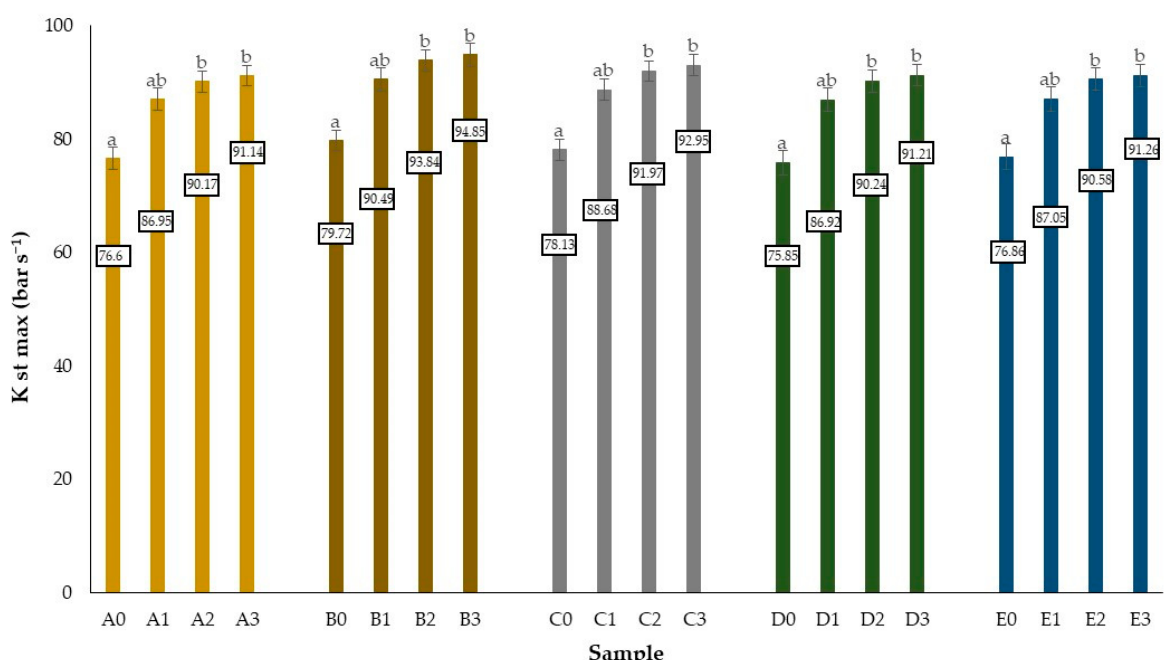
Figure 3. Explosivity indicator of dust of oak wood, bark, branches, leaves, acorns and produced biochars. Differences between average values described with the same alphabet signs are statistically insignificant at the level of p ≤ 0.05 based on the Duncan test. The data were analyzed separately for each type of materials.